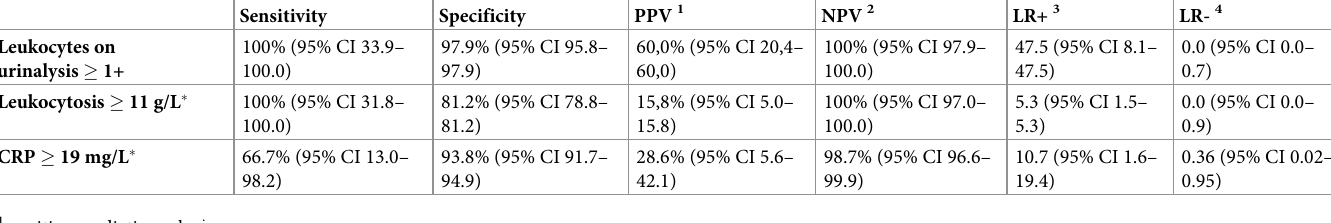
Table 1. Relationships between laboratory results and the presence of urinary tract infection.